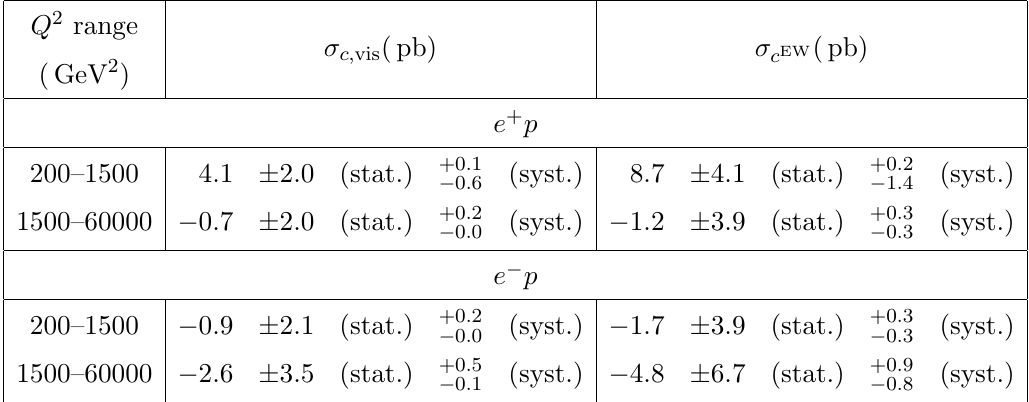
, for two Q 2 c EW